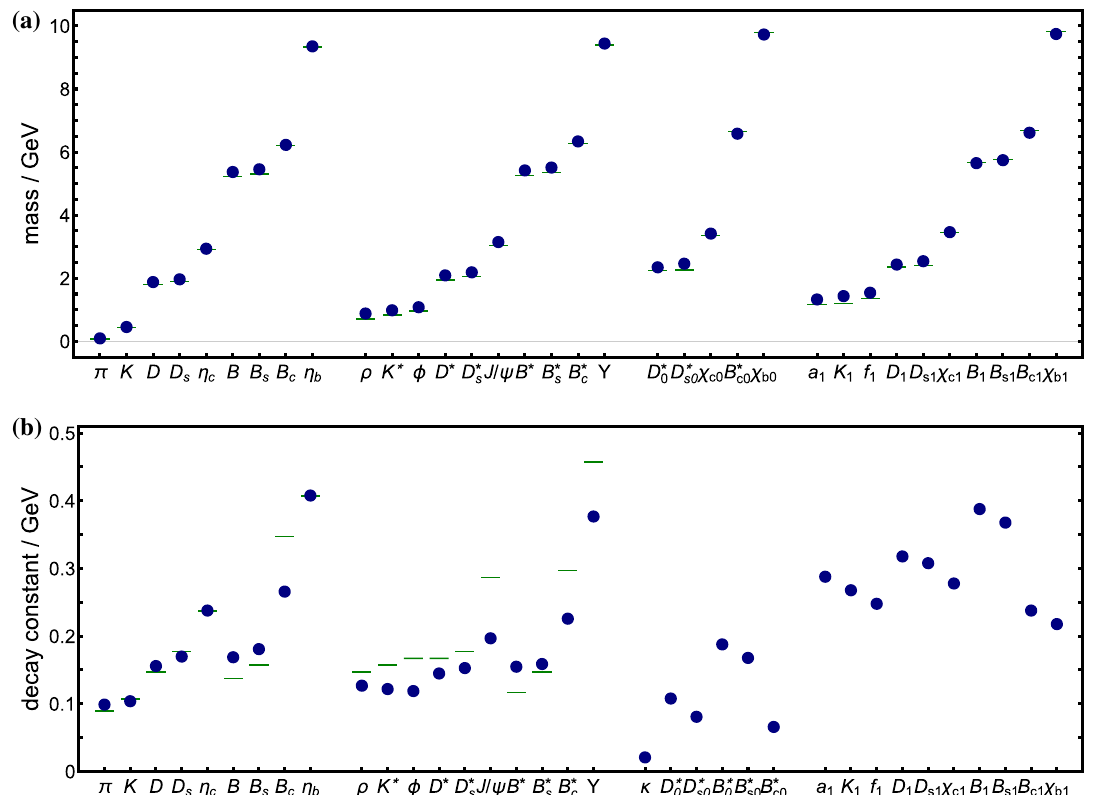
69].Inbothpanels,contact-interactionpredictionsaredepictedas(blue) circles and comparison values by (green) bars. (Pictorial , m B ∗ , m B from Ref. c 1 c c 0